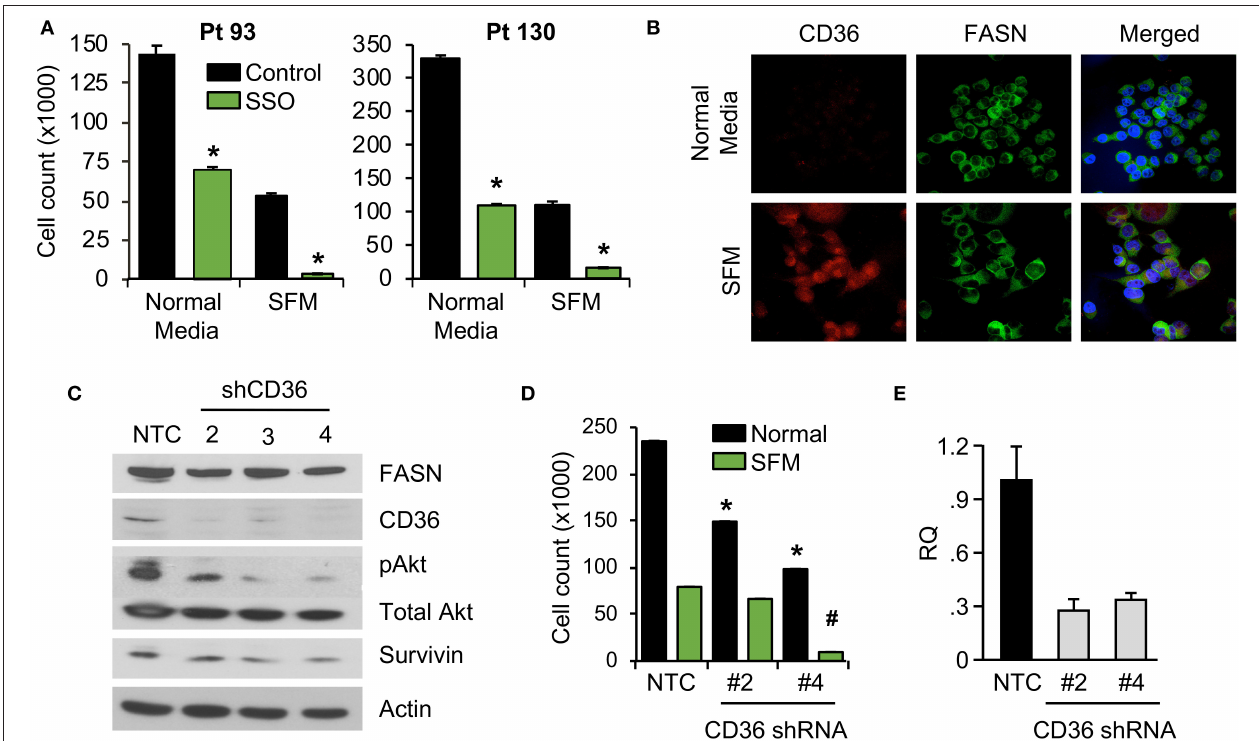
FIGURE 3 | Inhibition of CD36 is associated with decreased cellular proliferation. (A) Primary Pt 93 and Pt 130 CRC cells treated with 100 µ M SSO for 6 days. Cellular proliferation assays were performed via cell count. Representative data from three experiments is shown (* p < 0.05). (B) Confocal images of FASN and CD36 in Pt 93 cells in normal and serum free media (6 days). (C) Expression of proteins associated with apoptosis and survival in HCT116 transfected with CD36 shRNAs and analyzed via western blot. (D) Cellular proliferation assay with HCT116, NTC, and CD36 shRNA (* p < 0.05 for normal medium, # p < for SFM). (E) qRT-PCR confirmation of CD36 knockdown using CD36 shRNA #2 (73%) and CD36 shRNA #4